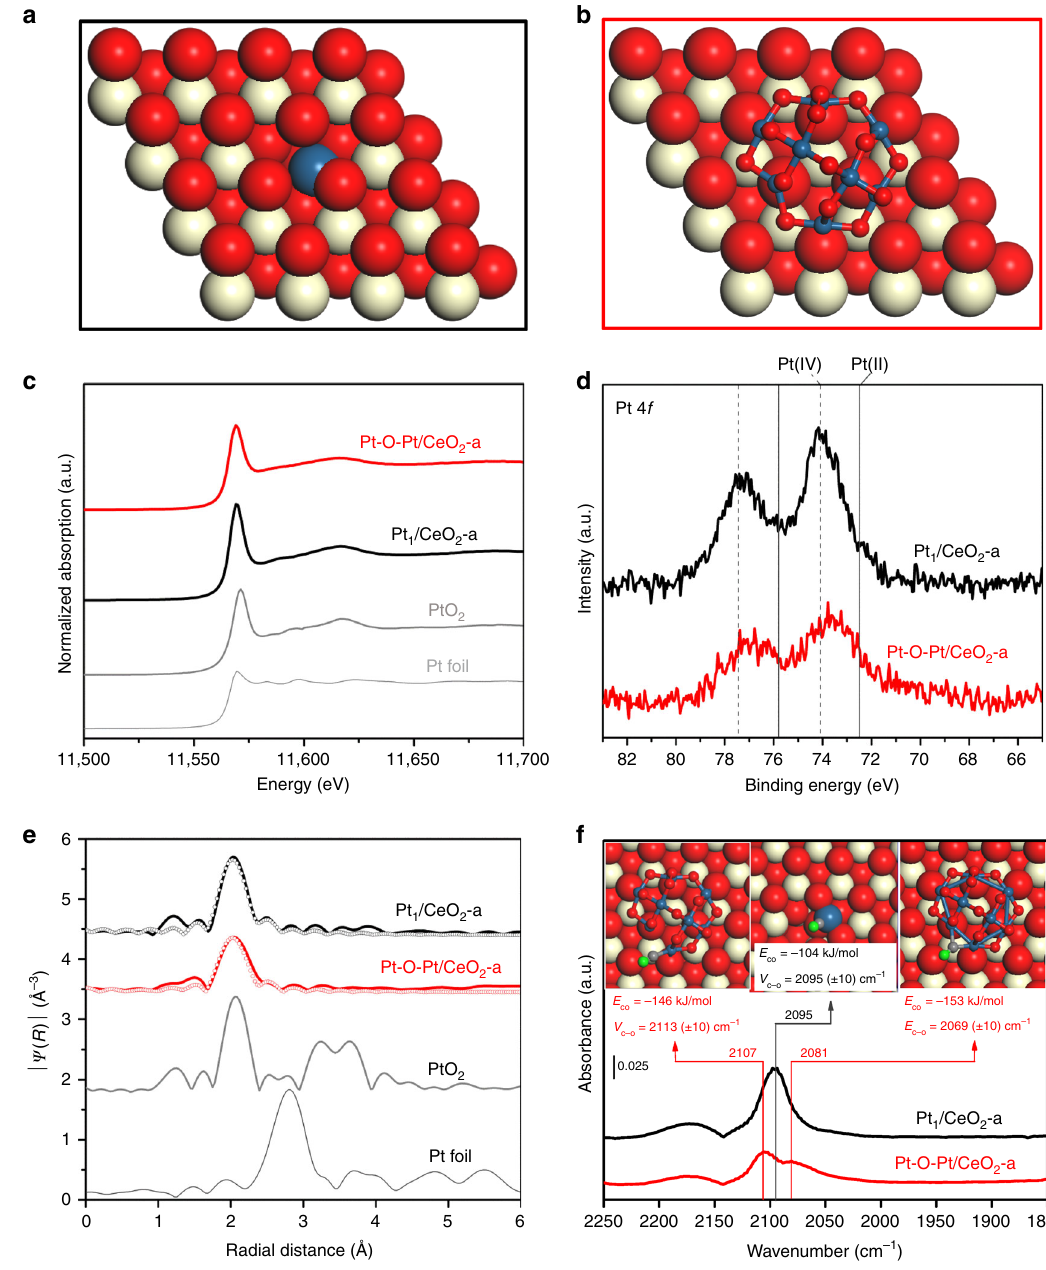
Fig. 2 The density functional theory (DFT)-optimized Pt structures and the material characterization results. a , b DFT-optimized structure of representative single-atom Pt in the Pt 1 /CeO 2 sample and Pt 8 O 14 in the Pt-O-Pt/CeO 2 sample found by grand canonical Monte Carlo-DFT (GCMC-DFT). c Normalized Pt L 3 edge x-ray absorption near-edge structure (XANES) spectra and d Pt 4 f x-ray photoelectron spectroscopy (XPS) spectra of the Pt 1 /CeO 2 -a and the Pt- O-Pt/CeO 2 -a catalysts. e Fourier transform of extended X-ray absorption fi ne structure (EXAFS) spectra of Pt L 3 edge (phase corrected) for the Pt 1 /CeO 2 - a and Pt-O-Pt/CeO 2 -a catalysts. The fi rst shell Pt-Pt coordination is not observed in the Pt 1 /CeO 2 and Pt-O-Pt/CeO 2 catalysts. The gray and red open circles are fi tted curves for the Pt 1 /CeO 2 and Pt-O-Pt/CeO 2 catalysts, respectively. The PtO 2 standard is in the β -phase. f In situ diffuse re fl ectance infrared Fourier-transform spectroscopy (DRIFTS) under the CO oxidation conditions for the Pt 1 /CeO 2 -a and Pt-O-Pt/CeO 2 -a catalysts. DFT-predicted CO adsorption modes are shown inset for Pt 1 /CeO 2 − x and Pt 8 O 13 /CeO 2 . Color legend of atoms: Ce = beige; Pt = blue; C = gray; O (in CeO 2 and Pt 8 O 13 ) = red; O (in CO) =